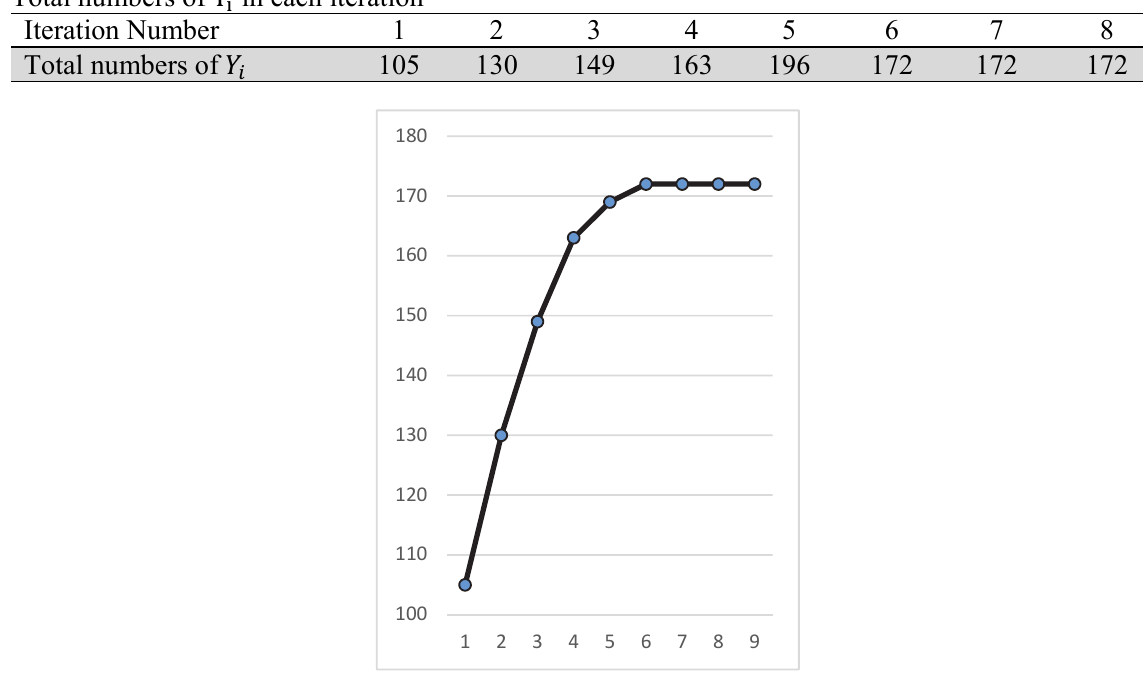
Fig. 3. Total numbers of Y